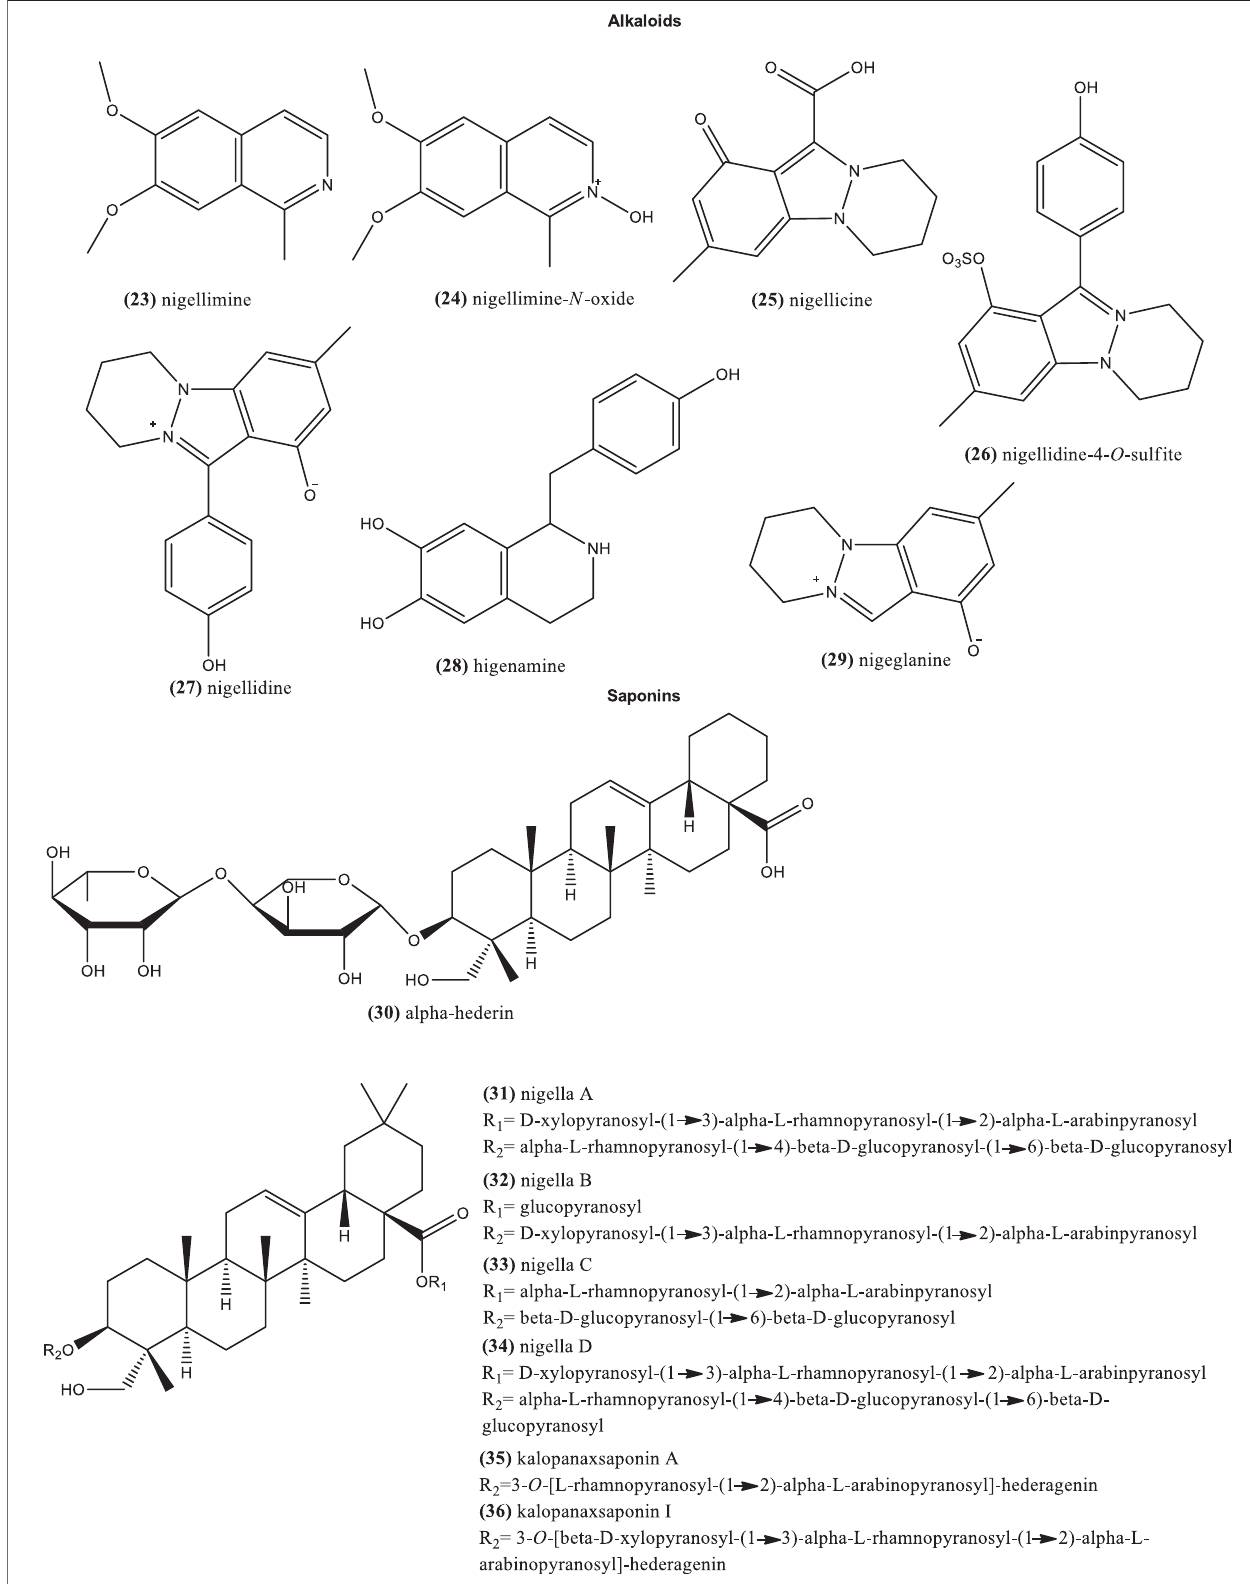
FIGURE 3 | Example of chemical structures of alkaloids and saponins reported in N. sativa .